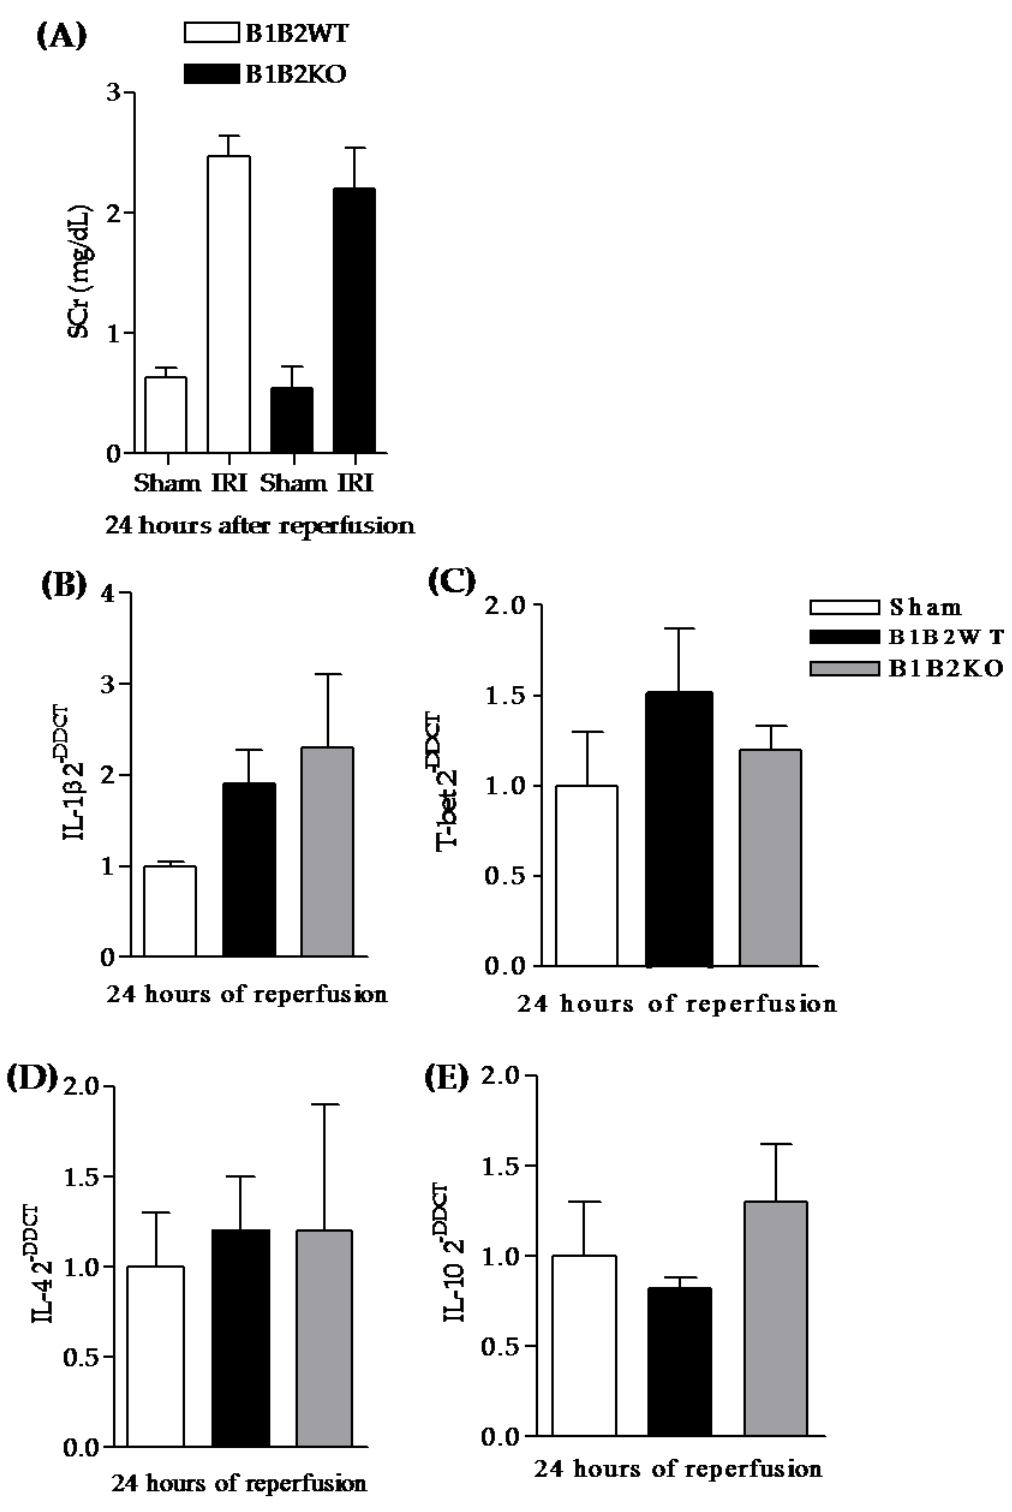
Figure 6. B1B2KO renal function and expression of pro and anti-inflammatory molecules. Renal function was estimated by serum creatinine levels measured using the modified Jaffe´ method. At 24 hours of reperfusion, B1B2KO presented high levels of serum creatinine and they were similar to wild-type mice (A). Thus, no renal protection was observed under simultaneous receptors deletion. Inflammatory molecule expressions were measured by real-time PCR. IL-1 b (B), T-bet (C), IL-4 (D) and IL-10 (E) expressions were similar between the double-knockout strain and wild-type mice. Statistical analyses were performed using the T-test.* B1B2KO versus B1B2WT, p , 0.05.